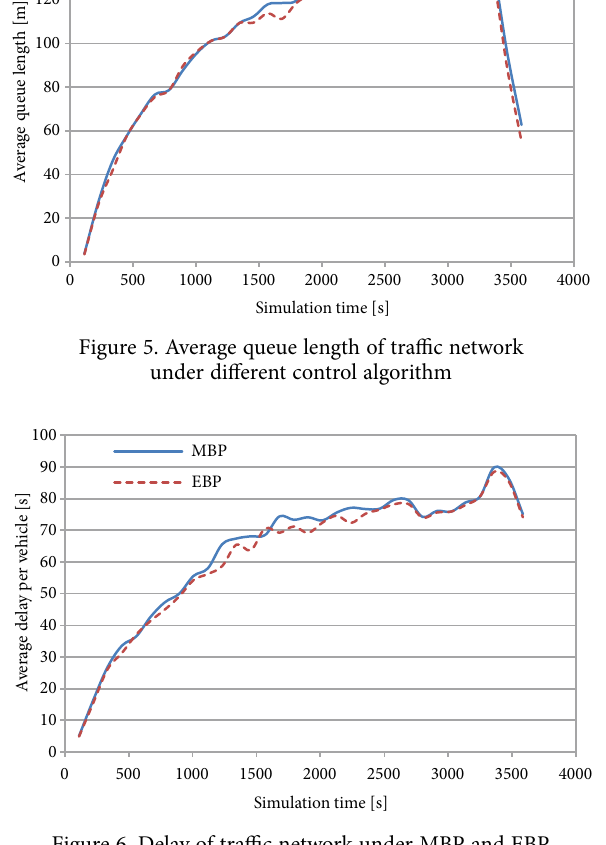
Figure 6. Delay of traffic network under MBP and EBP